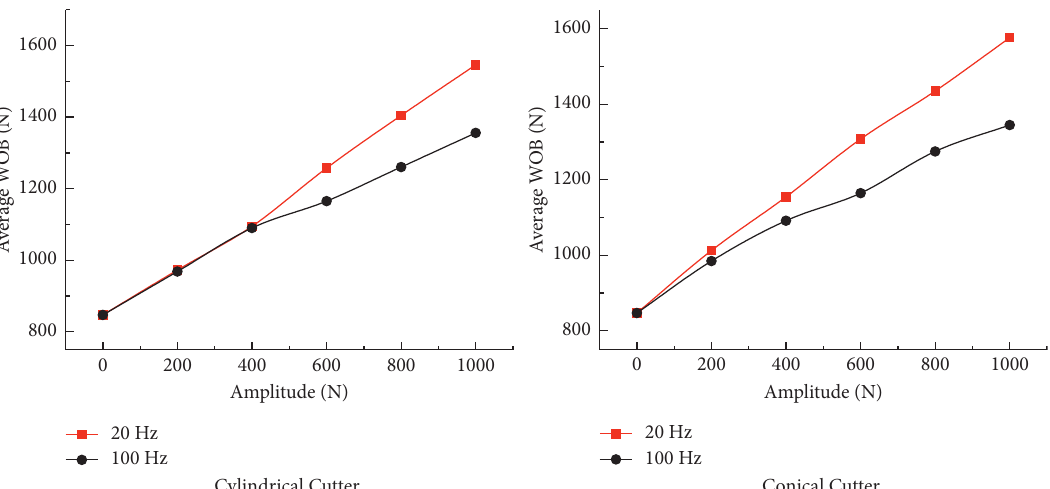
Figure 9: The effect of impact amplitude on average WOB.